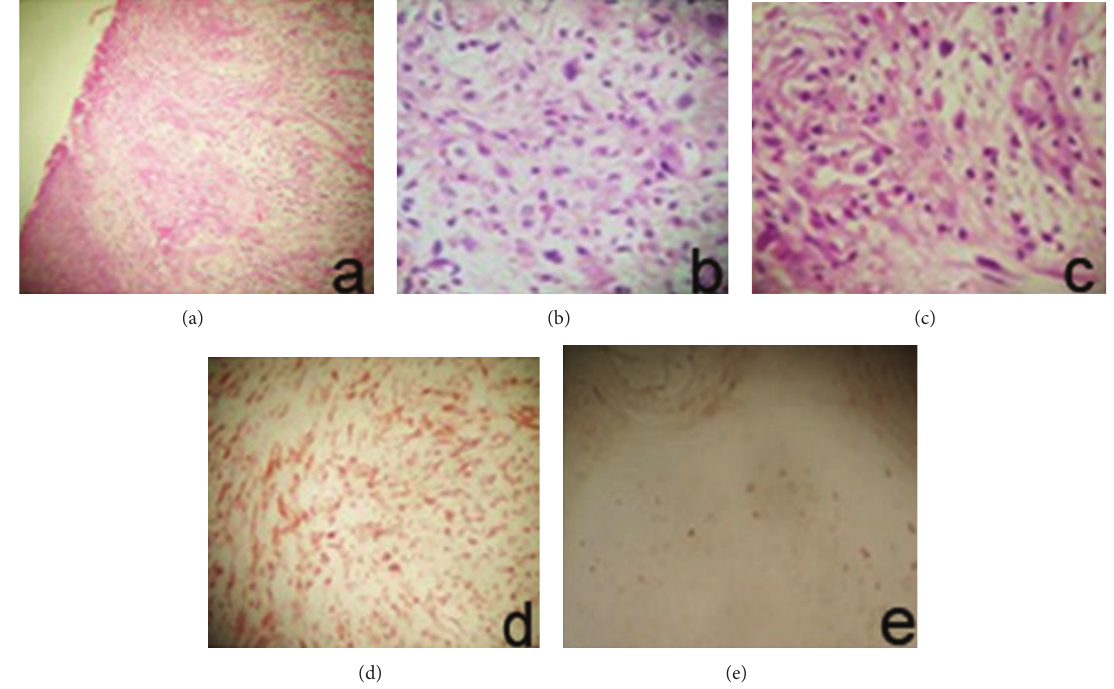
Figure 3: (a) Granulation tissue-like view with mucosal ulceration (H.E. × 100). ((b),(c)) Spindle-shaped structure pleomorphic cellular elements in granulation tissue (H.E. × 200). (d) Positivity of vimentin that shows mesenchymal phenotype of cells (immunohistochemistry, × 200). (e) HPV antigen positivity on the adjacent mucosa squamous epithelium (immunohistochemistry, ×